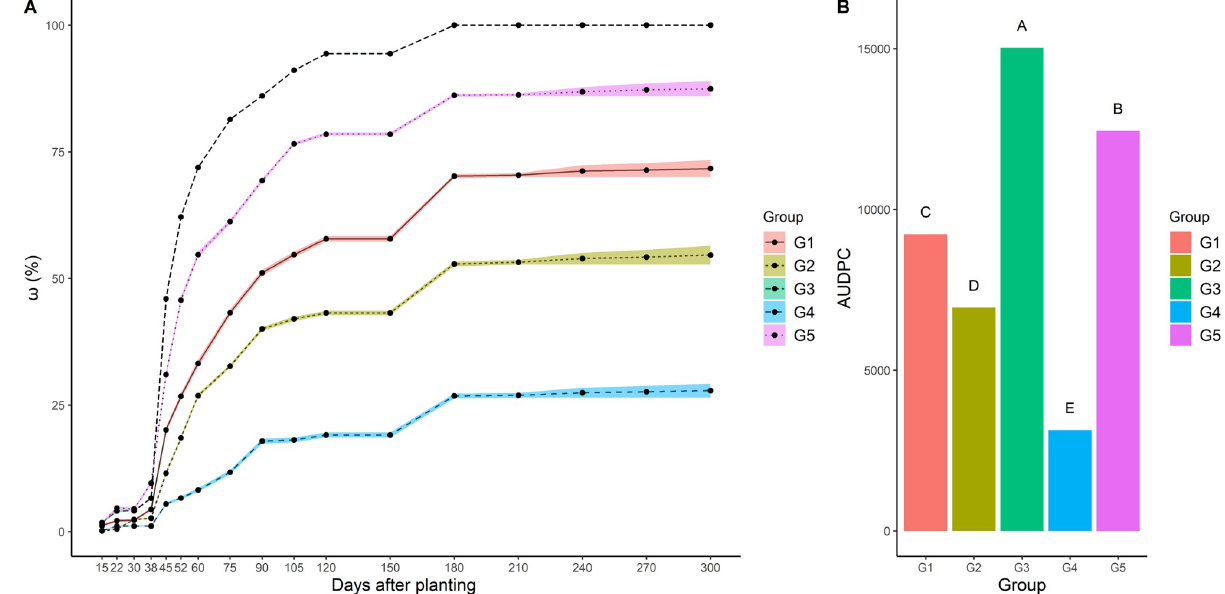
Fig 3. Mean values for the disease index ( ω ) and area under the disease progress curve (AUDPC) of the five groups formed via cluster analysis from the 148 cassava genotypes evaluated in areas infested by root rot pathogens between 15 and 210 days after planting. Means followed by the same letter belong to the same group based on the Scott-Knott test (p <